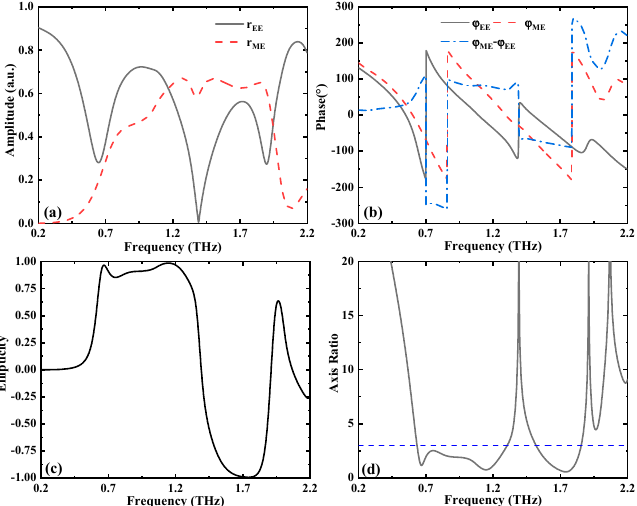
Figure 2. Calculated ( a ) reflection coefficients amplitudes and ( b ) phases (phase difference) for TE- polarized normal incident terahertz wave. Calculated ( c ) ellipticity and ( d ) axis ratio of the structure with TE polarization incident.